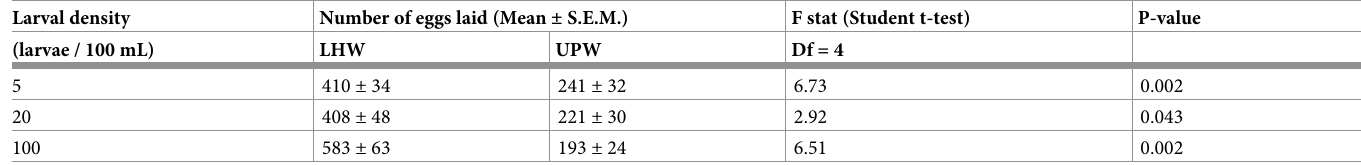
Table 1. Oviposition responses (number of eggs laid) of Ae . aegypti gravid females towards larval holding water (LHW) at different densities compared to ultrapure water (UPW). Larval density Number of eggs laid (Mean ±